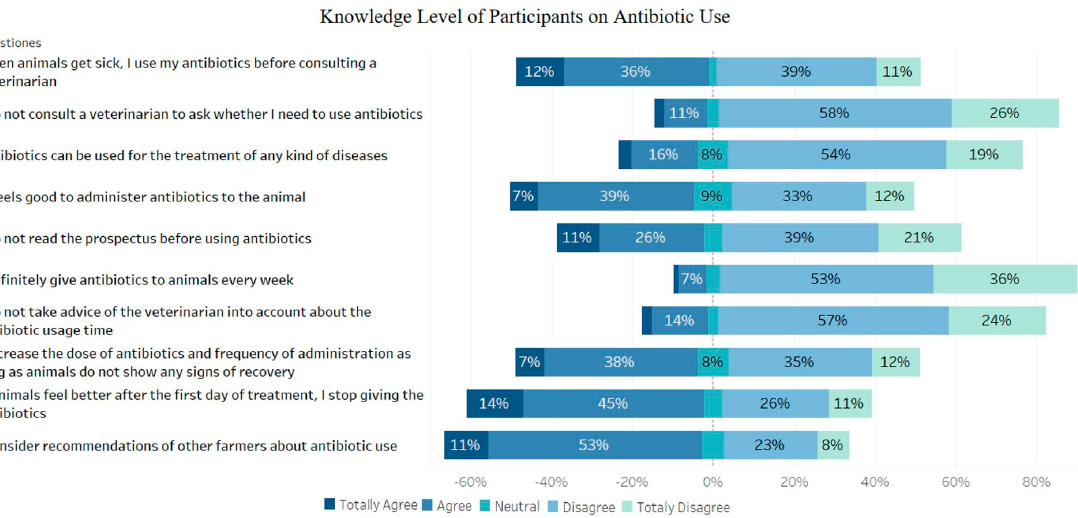
Figure 3. Knowledge level of participants on antibiotic use.